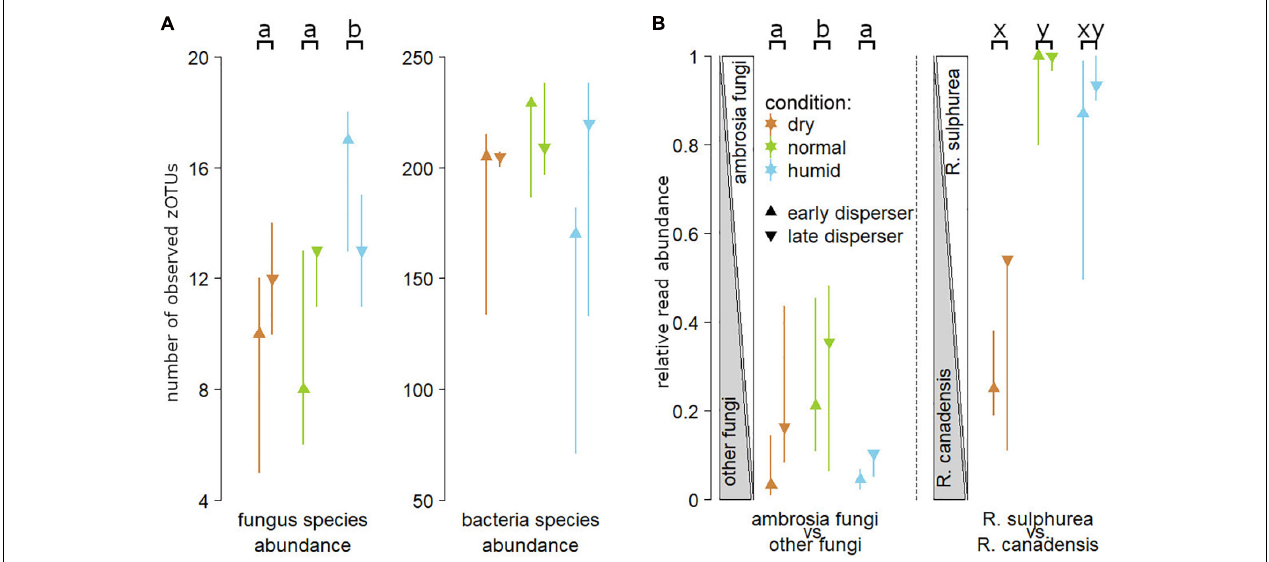
FIGURE 4 | Panel (A) illustrates the numbers of zero radius Operational Taxonomic Units (zOTU, ≈ number of clearly distinguishable species) for fungus and bacteria species that are carried by first (“early”) or last (“late”) dispersing females from nests reared in “normal,” “dry” and “humid” substrate during the humidity experiment . Panel (B) illustrates the relative read abundance of ambrosia fungi over all fungi, and the relative read abundance of the two main ambrosia fungus species carried by Xyleborinus saxesenii females, Raffaelea sulphurea and Raffaelea canadensis. Medians and interquartile ranges are shown. Different lower case letters in the top line indicate statistically significant differences within each panel (TukeyHSD; P <